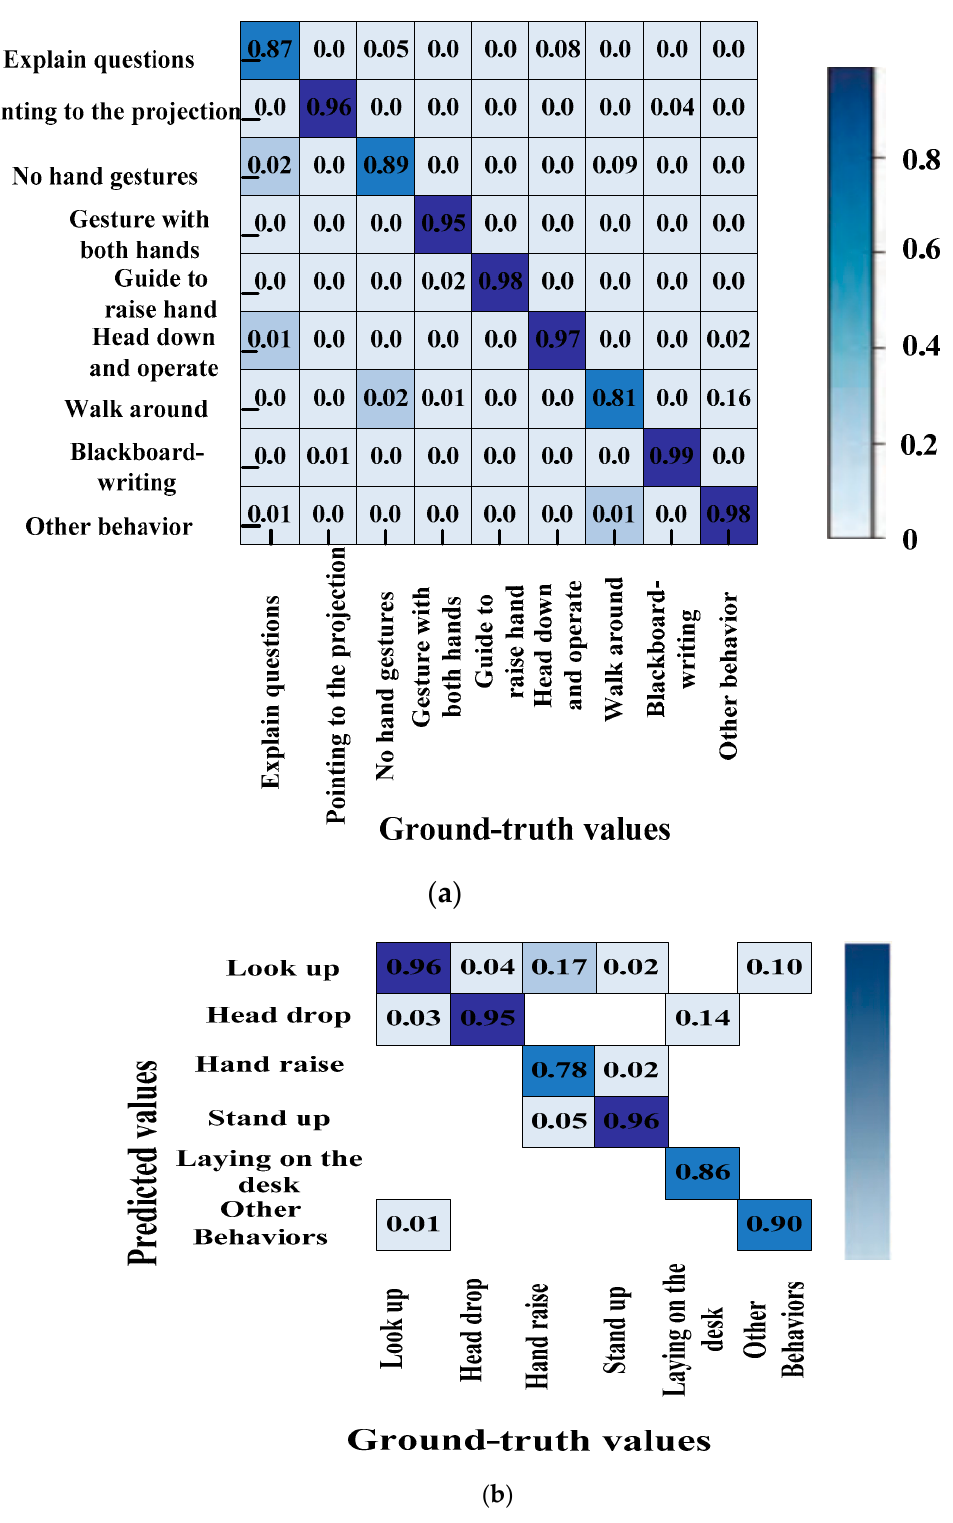
Figure 6. Results in the confusion matrix. ( a ) Teacher behavior recognition results; ( b ) student behavior recognition results.